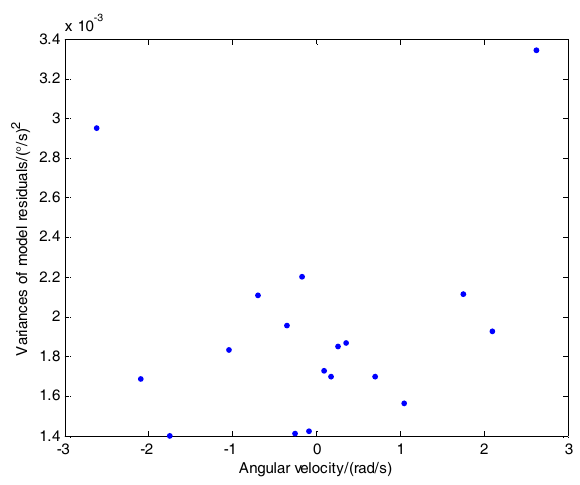
Figure 4. Remaining random noise variance.